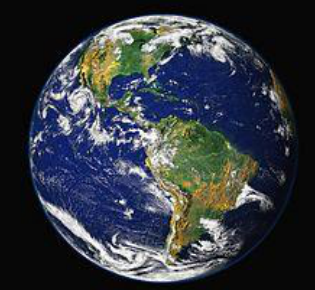
Figure 2. One of the most famous photographs of Earth, taken on December 7, 1972 by the Apollo 17 crew from ~ 45,000 km